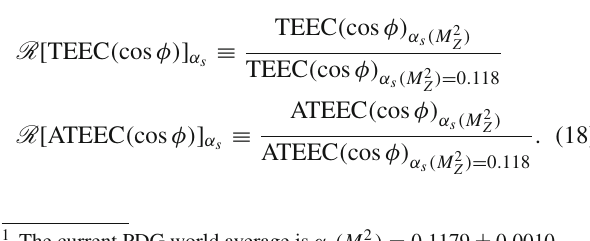
Fig. 10 A comparison of the LO and the NLO differential distribution 1 /σ (cid:7) d (cid:9) (cid:7) / d ( cos φ) (left) and its asymmetry 1 /σ (cid:7) d (cid:9) (cid:7) asym / d ( cos φ) (right) √ s = 314 GeV) in the high- Q 2 range (upper frames) and low- Q 2 range (lower frames), with μ F = μ R = μ 0 = at HERA ( α ( M 2 ) = 0 . s Z